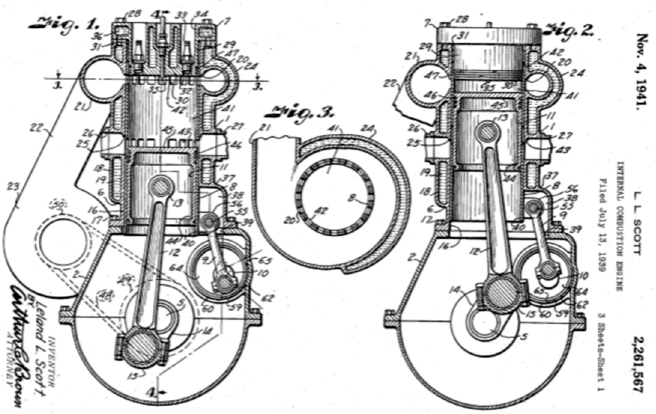
Figure 10. L.L. Scott GM, 13 July 1939: Internal combustion engine US 2261156. Reproduced with